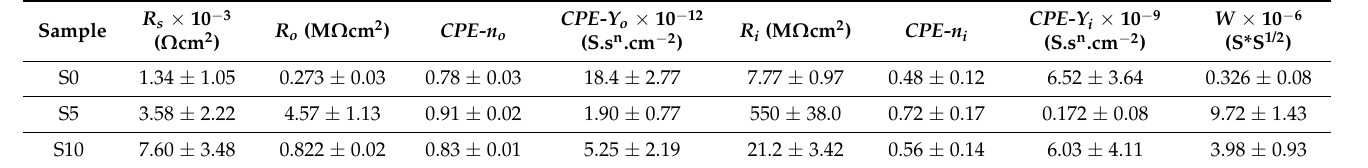
Table 2. Results of the EIS tests of the S0, S5, and S10 samples immersed for 6 h in a 3.5% NaCl solution. Sample